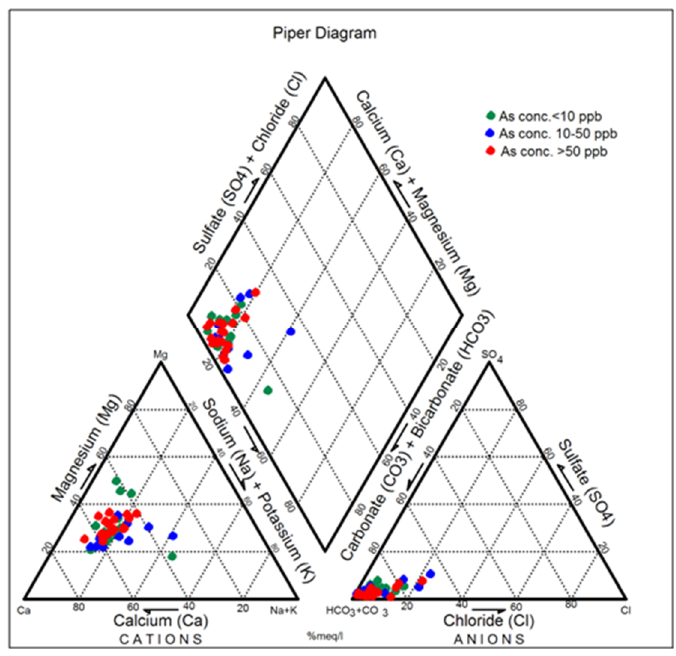
Figure 8. Piper diagram showing the ionic nature of groundwater.